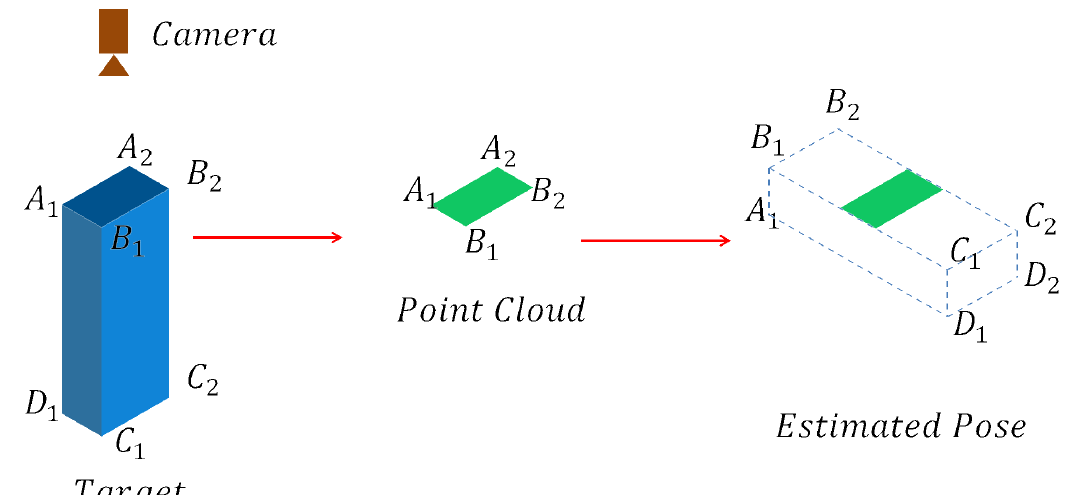
Figure 6. ( Left ) the camera is above the target cuboid; ( Middle ) only a small part of the target (plane A 1 B 1 B 2 A 2 ) is taken; ( Right ) after voting with the hash table, the pose with the highest vote is wrong.